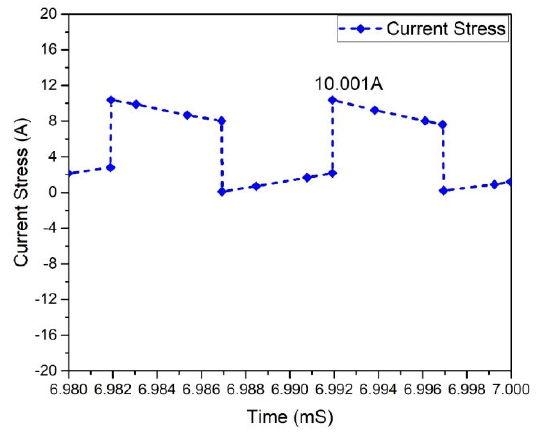
Figure 30. Current stress of HEMT.